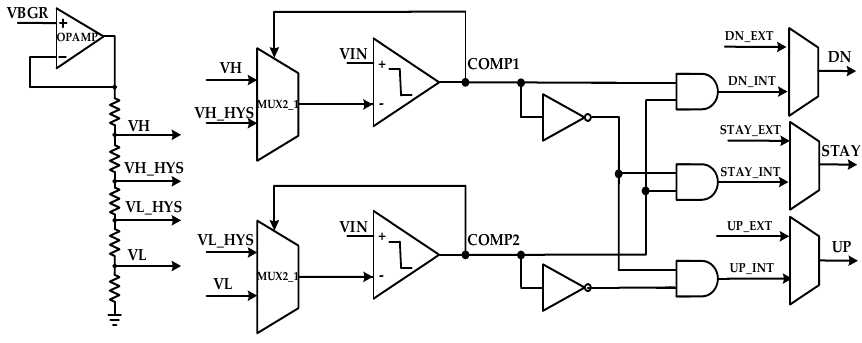
Figure 3. Hysteresis triple-mode selector diagram.